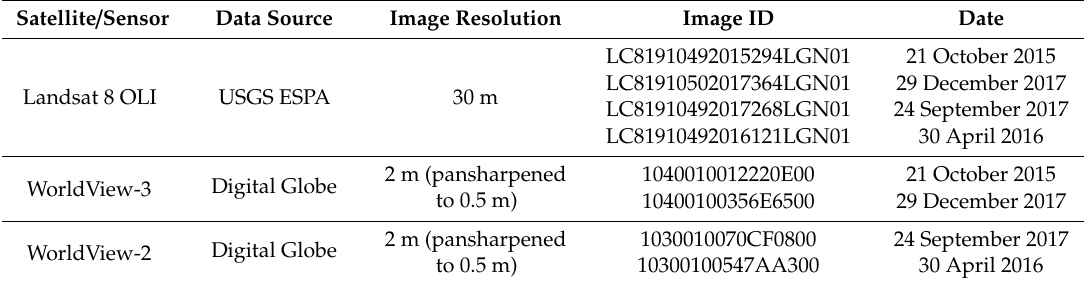
Table 1. Landsat and DG imagery used.